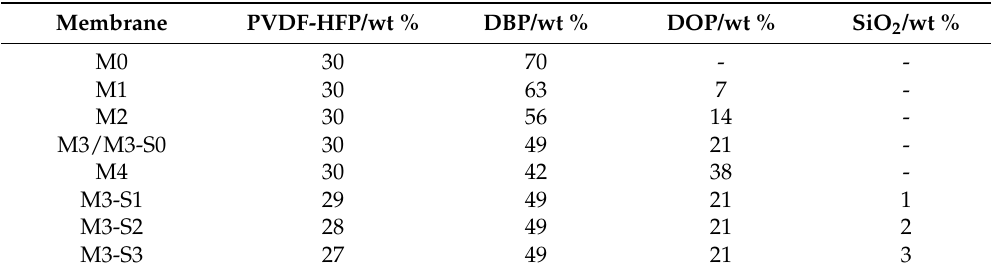
Table 1. The composition of the obtained PVDF-HFP